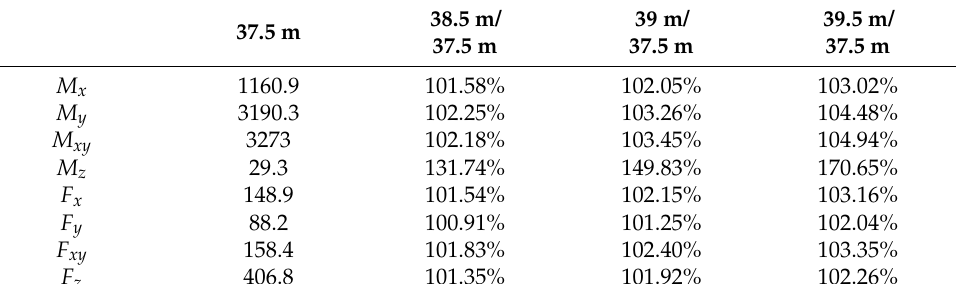
Table 13. Ultimate loads at blade root.